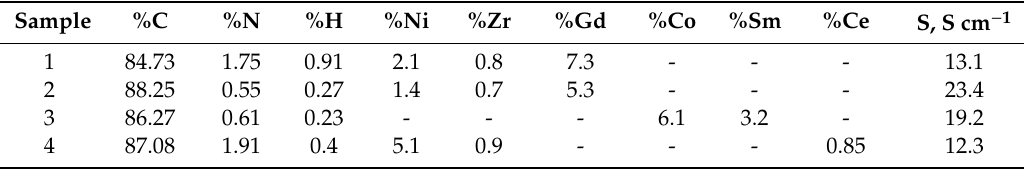
Table 1. Elemental content and electrical conductivity for carbon nanofiber (CNF)-based